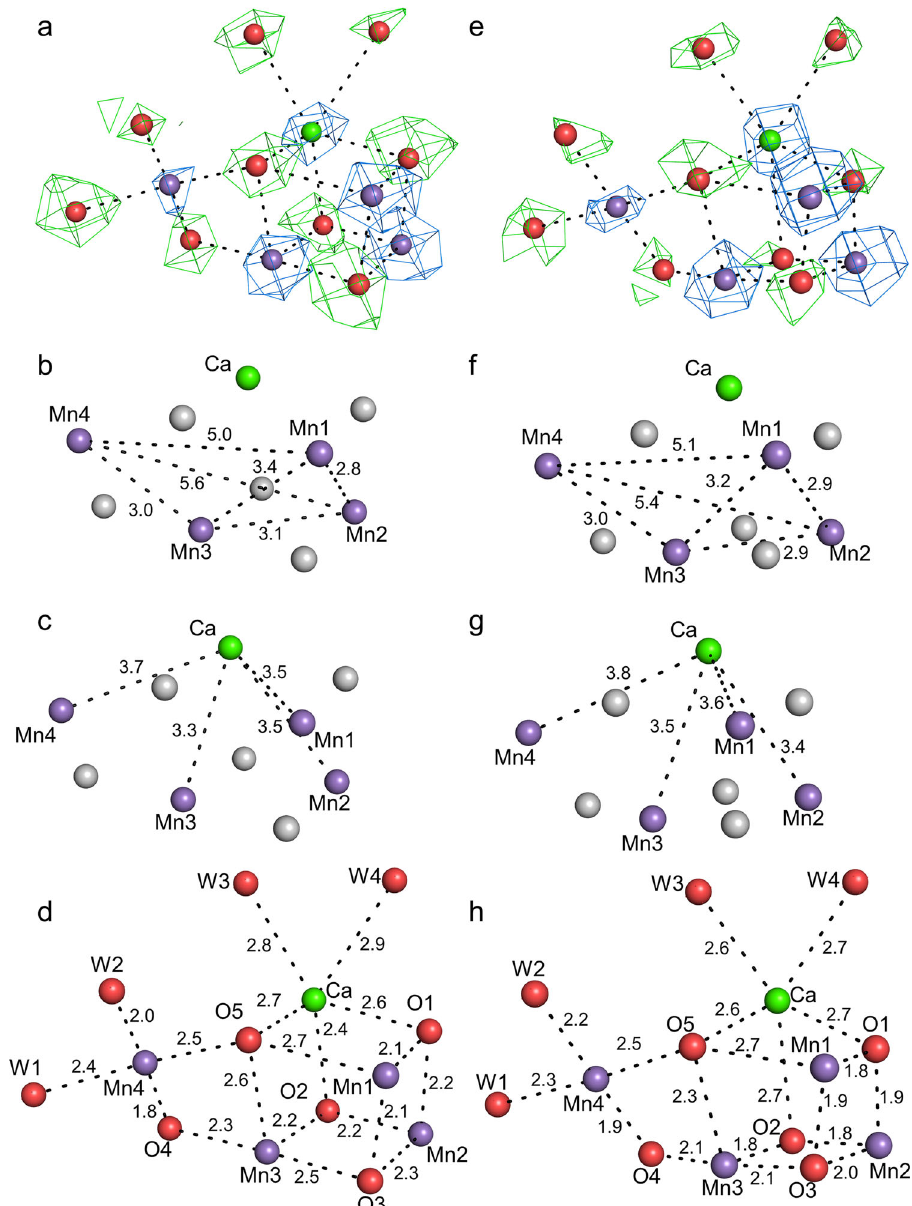
Fig. 4 Electron beam damages in the OEC structure solved at the high-dose (83 e − Å − 2 ) and low-dose (3.3 e − Å − 2 ). a – d High dose structure. a The cryo-EM density (blue) for manganese and calcium atoms at 17 σ and the subtracted map (green) for oxygen atoms and water molecules at 7 σ . b Mn – Mn distances in OEC (Å). c Mn – Ca distances in OEC (Å). d Mn – O, Ca – O, Mn – water and Ca – water distances in OEC (Å). e – h Low dose structure. e The cryo- EM density (blue) for manganese and calcium atoms at 17 σ and the subtracted map (green) for oxygen atoms and water molecules at 7 σ . f Mn – Mn distances in OEC (Å). g Mn – Ca distances in OEC (Å). h Mn – O, Ca – O, Mn – water, and Ca – water distances in OEC